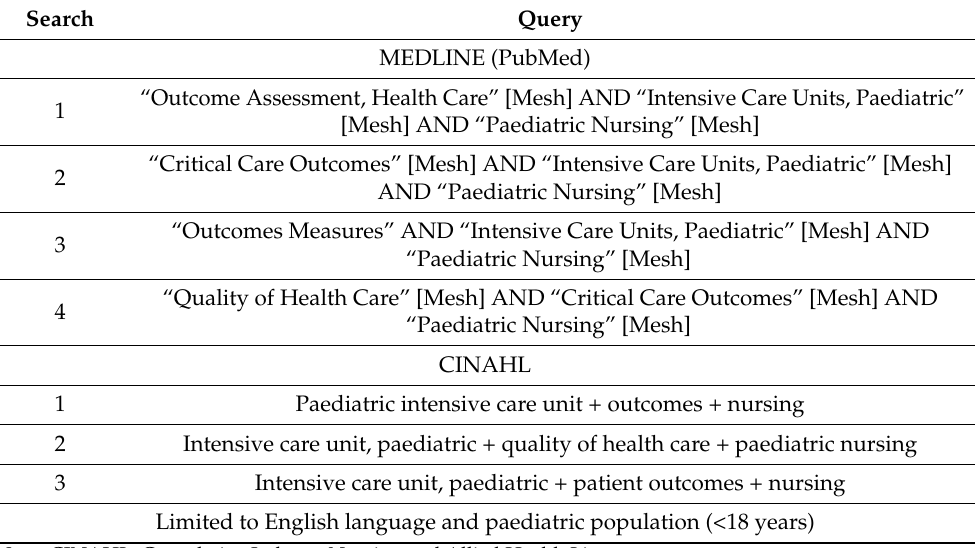
Table 1. Literature search strategy for MEDLINE (PubMed) and CINAHL, conducted in April 2020.